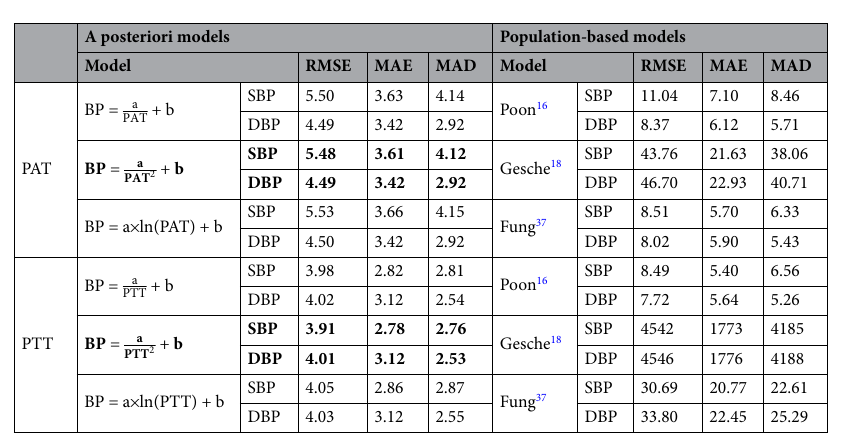
Table 3. Evaluation of different models for estimating BP from PAT or PTT. All values are given in units of mmHg. Best performing models for PAT and PTT are highlighted in bold.